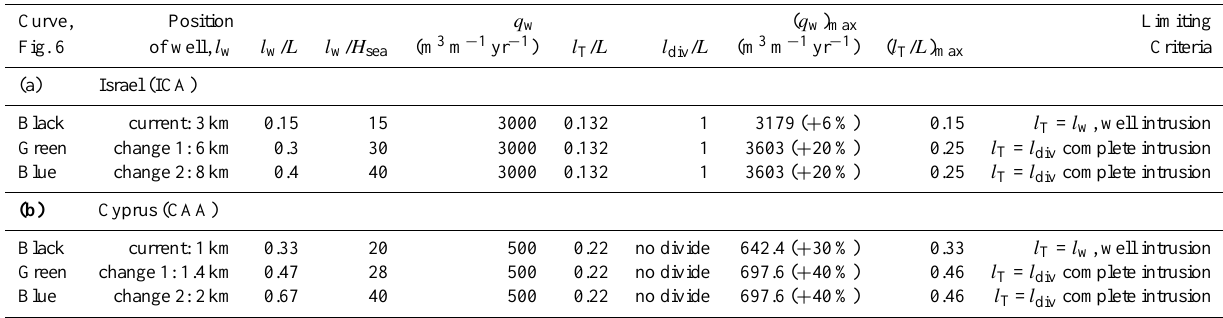
Table 3. Variable quantification related to the results of Fig. 6 for the Cyprus Akrotiri aquifer and the Israel Coastal aquifer. Quantified variables include groundwater exploitation (current pumping rate q w , possible maximum pumping rate ( q w ) max ), pumping l w in relation to aquifer length L , intrusion toe position l T / L and ( l T / L) max for q w and ( q w ) max pumping, respectively, and relative location l div / L of a possible groundwater divide formed between the well and the